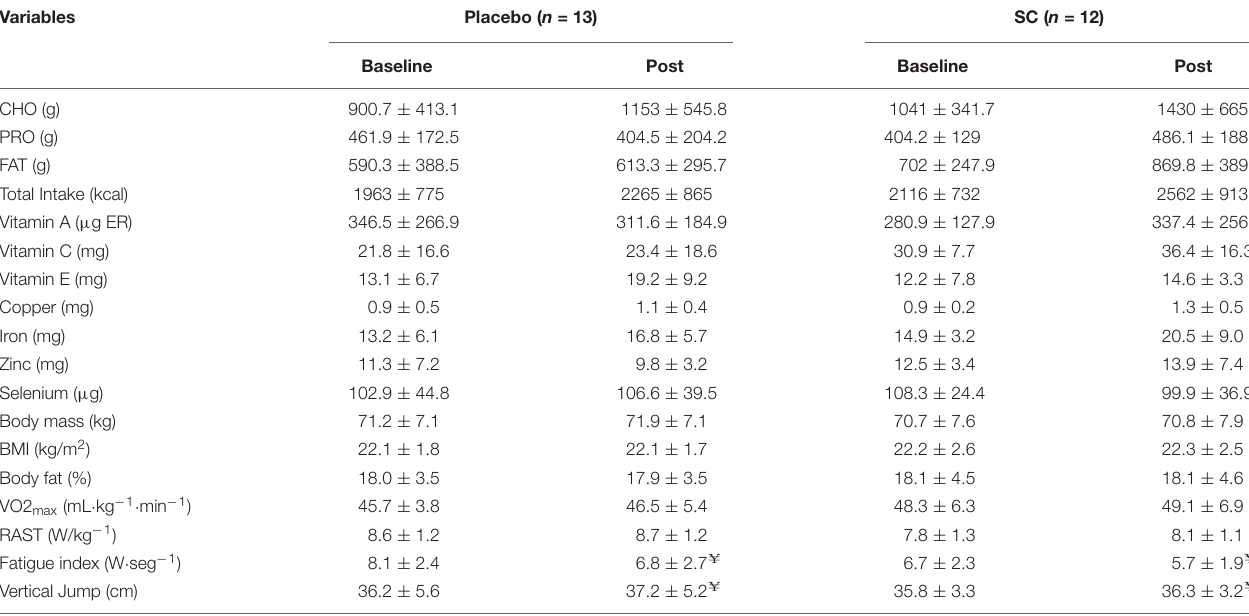
TABLE 2 | Comparison between placebo and supplementation group on dietary intake, anthropometry and performance. Variables